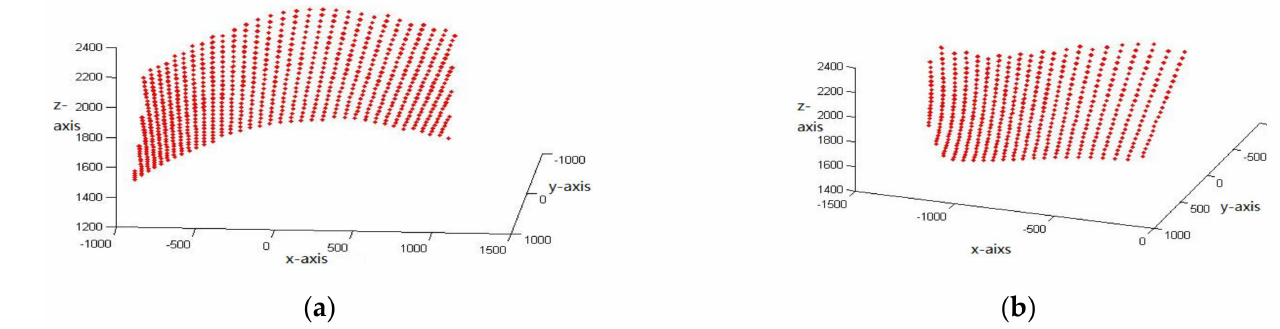
Figure 12. Three-dimensional point cloud map of the projector’s projection area. ( a ) P1 projection, with C1 acquisition, and ( b ) P1 projection, with C2 acquisition.